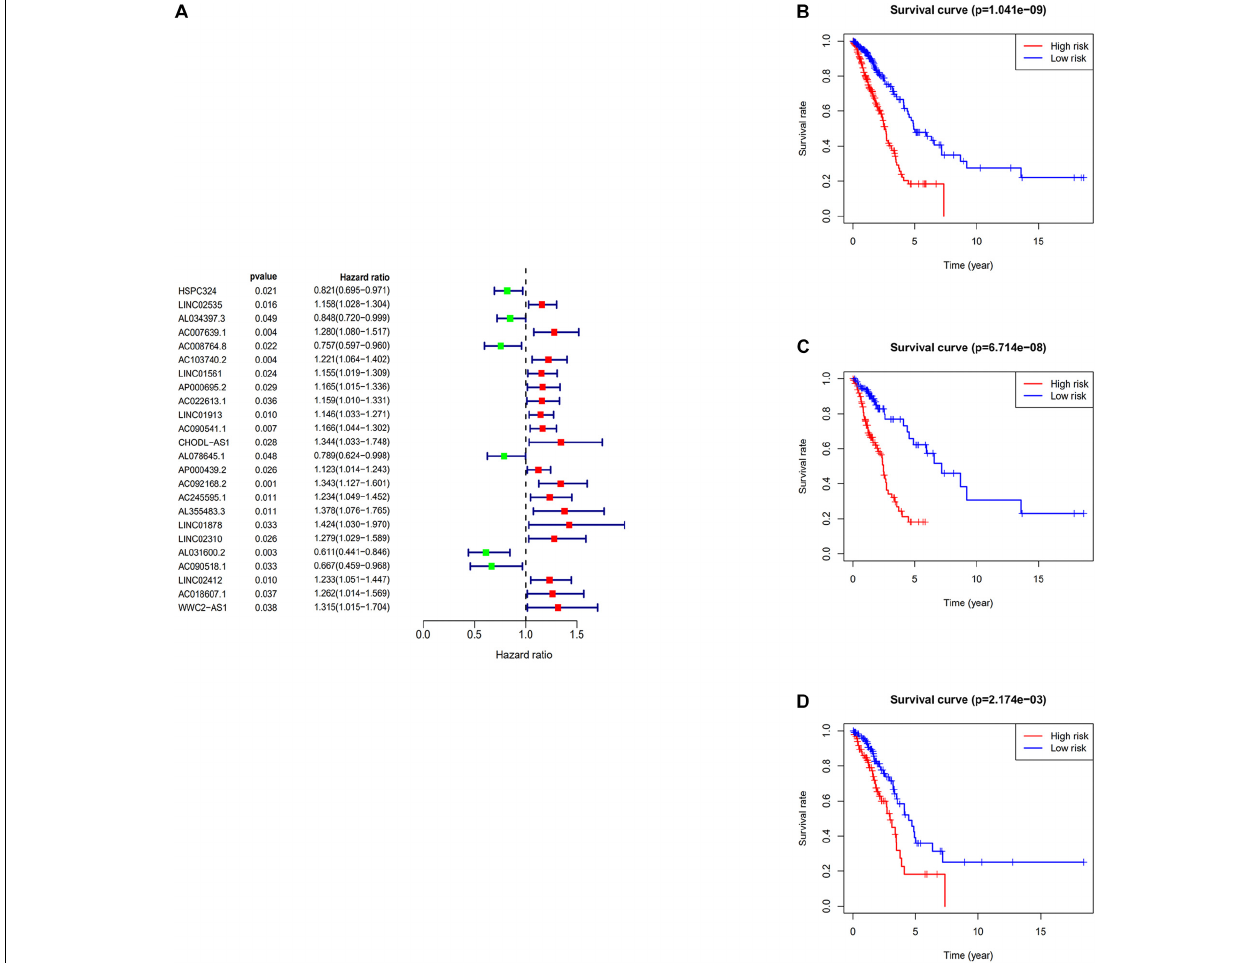
FIGURE 2 | Construction of the prognostic risk score model. (A) Forest plot of univariate Cox regression analysis results of Immune-related lncRNAs. Red and green indicate risk and protective factors, respectively. (B) K–M survival curve of the immune-related lncRNA signature in the TCGA dataset. (C) K–M survival curve of the immune-related lncRNA signature in the training set. (D) K–M survival curve of the immune-related lncRNA signature in the testing